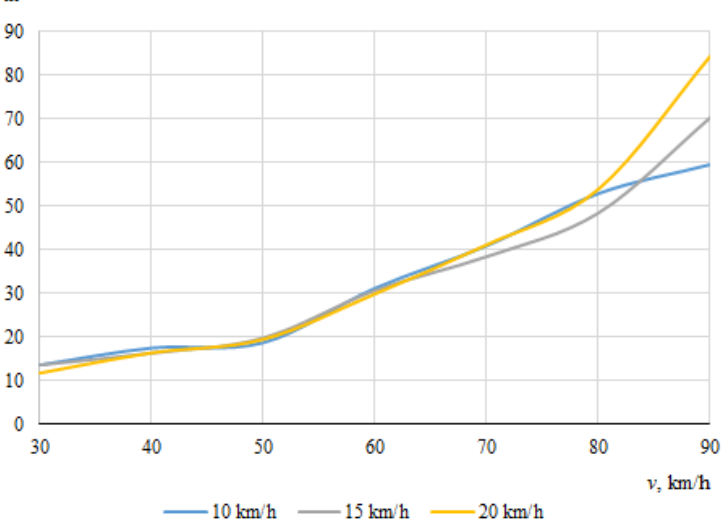
Figure 15. Throwing distances of the cyclist (impact angle 60°).